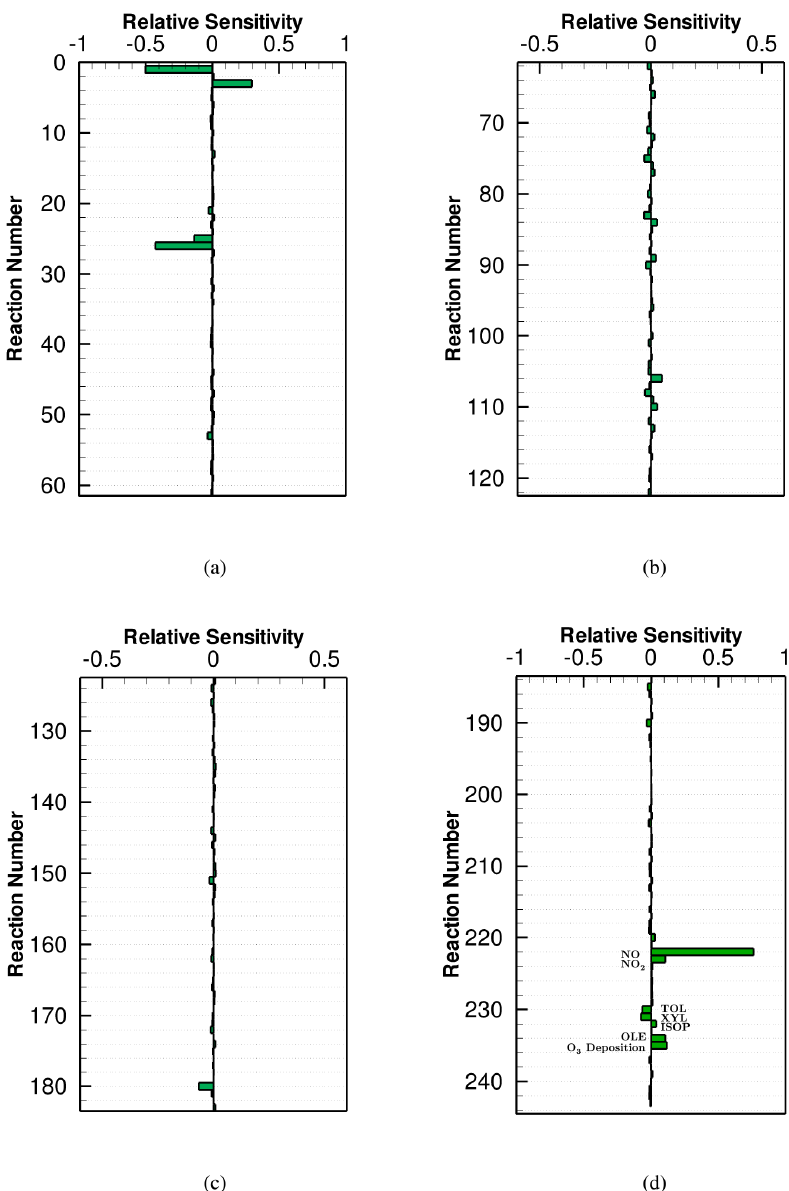
Figure 7. Averaged NO x sensitivity to the CB6r3 mechanism over the seventh day, when the surface emission is strong. All the values of the sensitivities shown in this figure can be found in Table